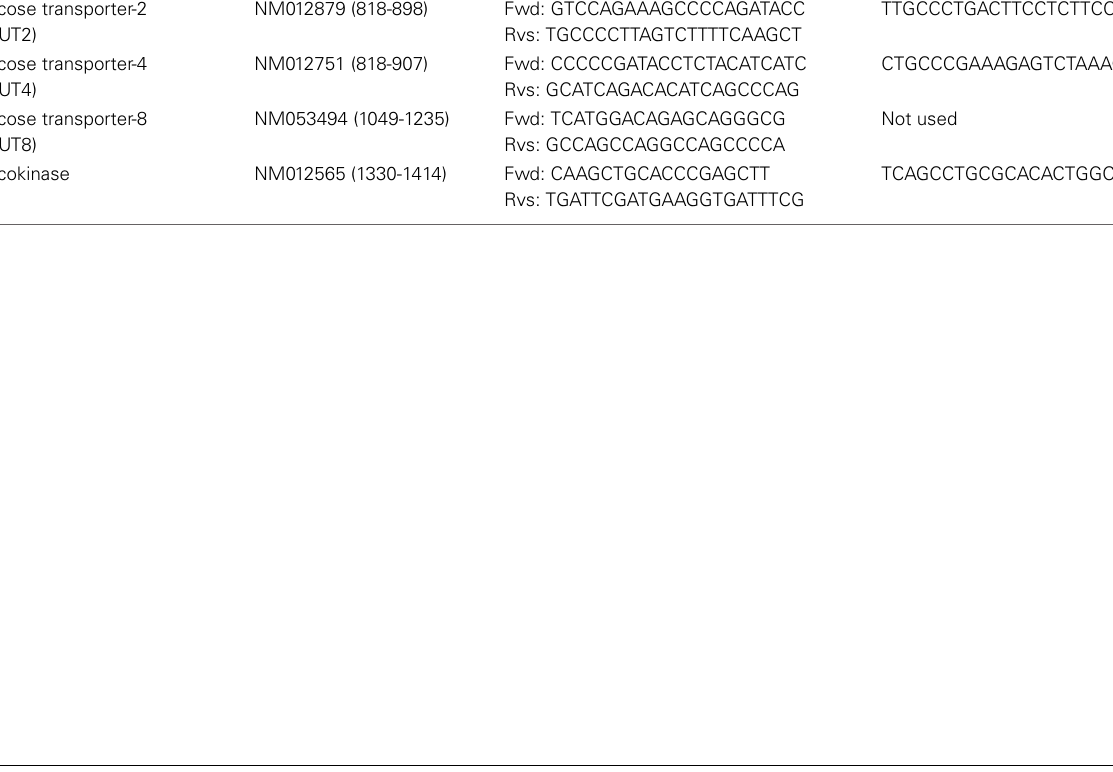
Table A1 | Primer sequences used for real-time RT-PCR. mRNA